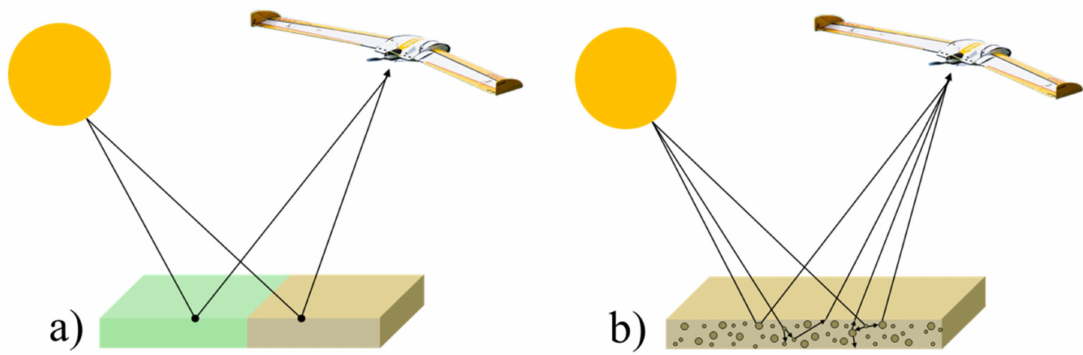
Figure 1. ( a ) Mixed pixel composed of a linear mixture of two surface materials illustrating the “aeral mixture” (green: vegetation, brown: bare soil) and ( b ) mixed pixel composed of a volumetric distribution of intimate soil constituents illustrating the “intimate